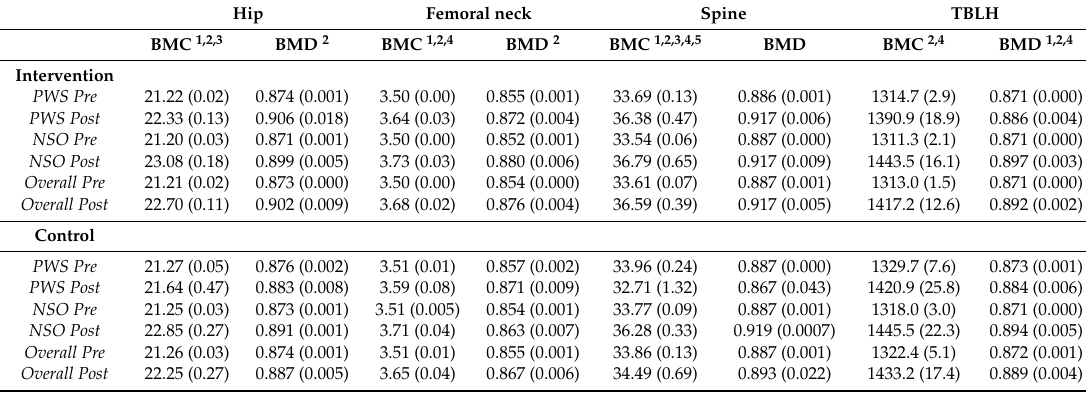
Table 2. Changes in bilateral hip ( n = 111), spine ( n = 107) and total body less head ( n = 80) bone parameters by intervention groups in youth with Prader-Willi syndrome (PWS) and youth with non-syndromic obesity (NSO). Hip Femoral neck Spine TBLH